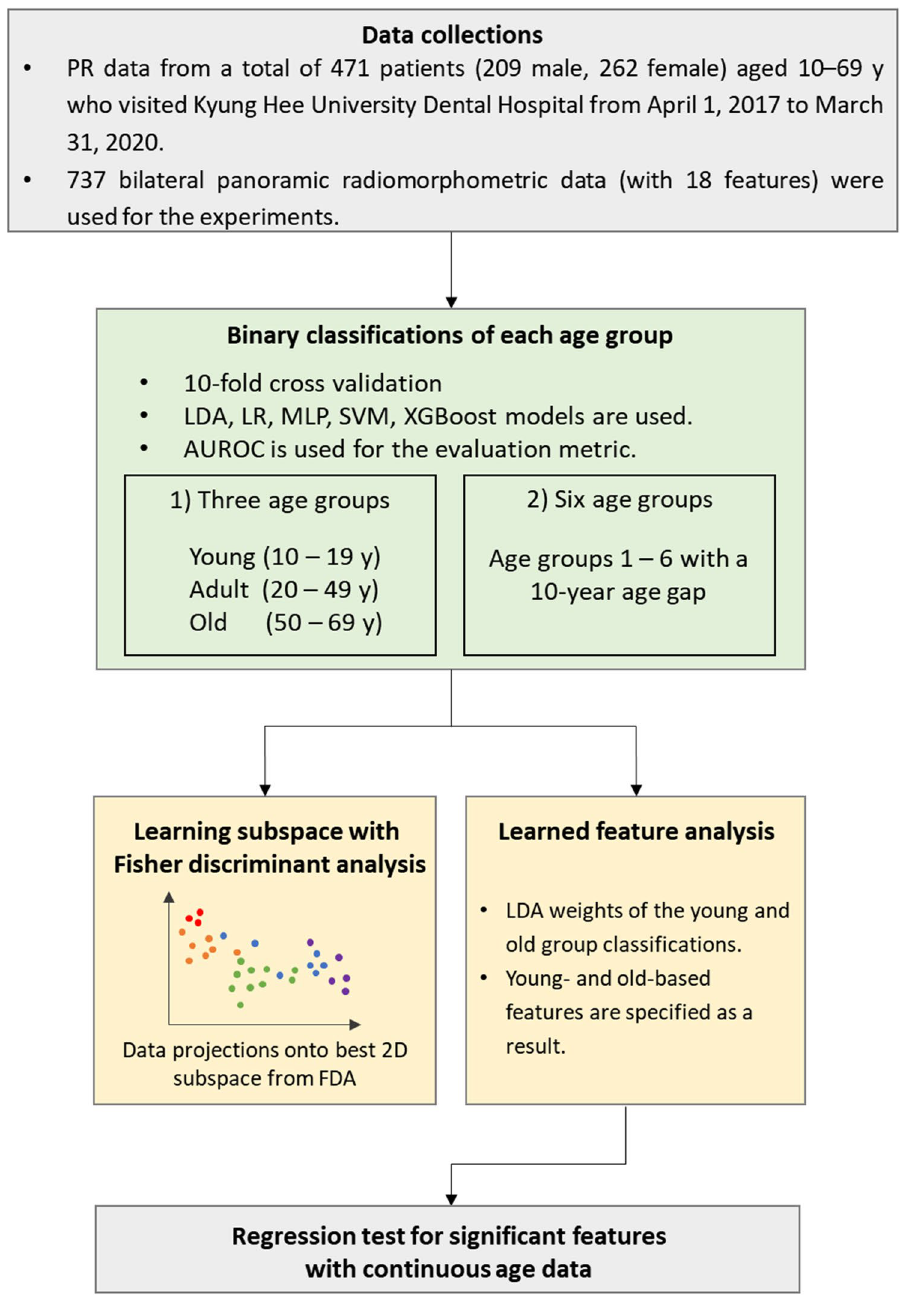
Figure 1. Flow chart of the present study. LDA linear discriminant analysis, LR logistic regression, SVM kernelized support vector machines, MLP multilayer perceptron, XGBoost extreme gradient boosting. Lastly, Fisher discriminant analysis (FDA) was used to visualize the data